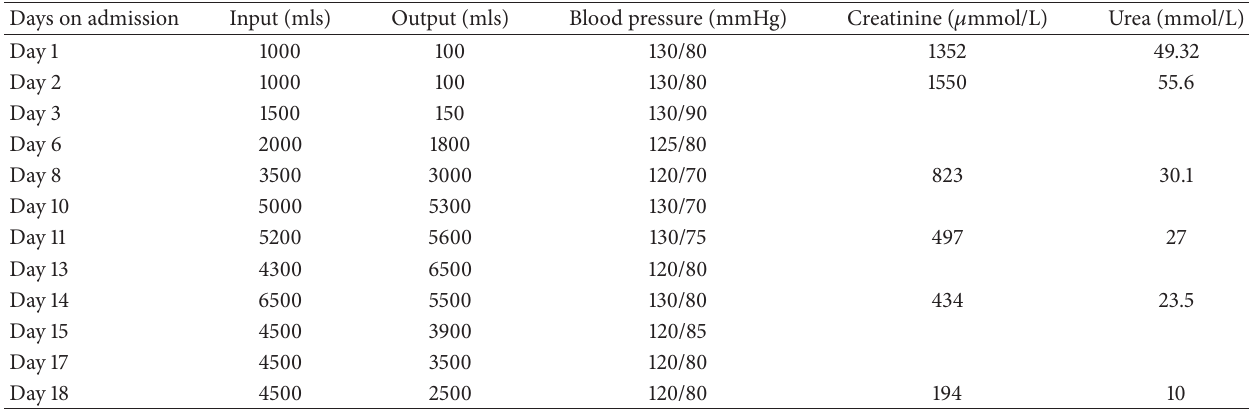
Table 1: Input-output chart and blood